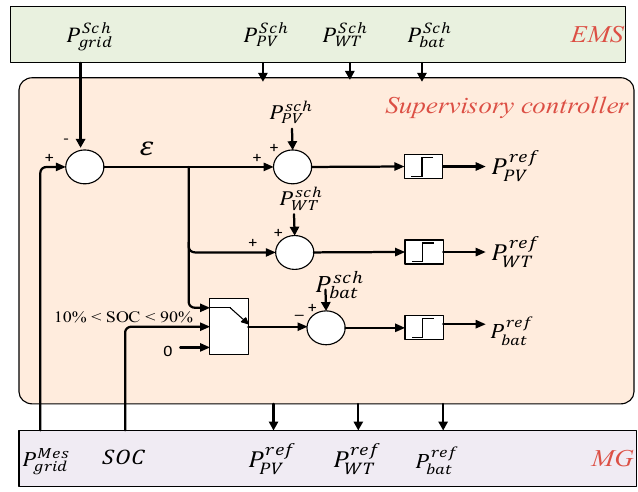
Figure 9. Supervisory controller design. SOC: state of charge; MG: microgrid.